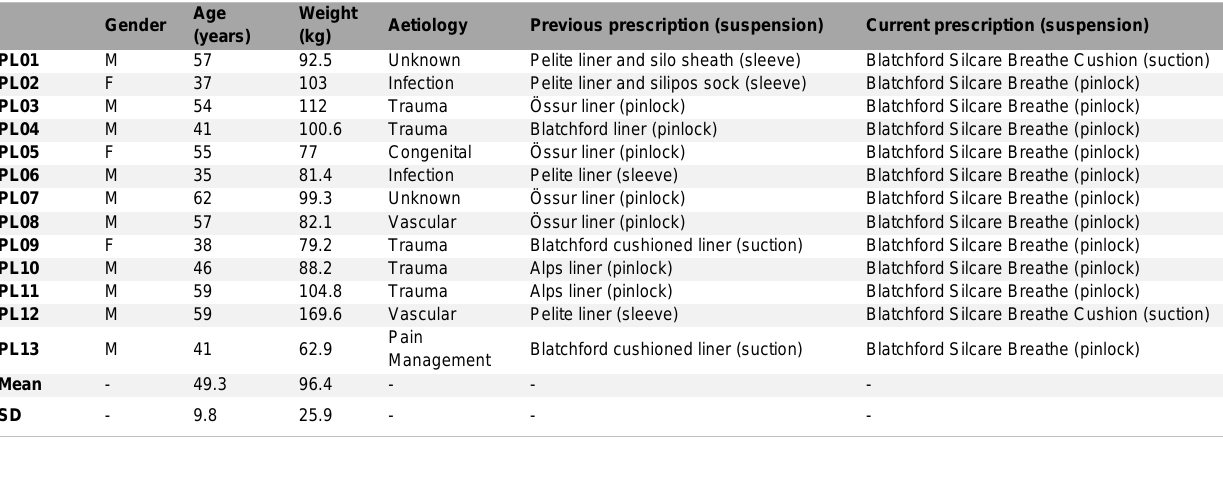
Table 1: Study group participant